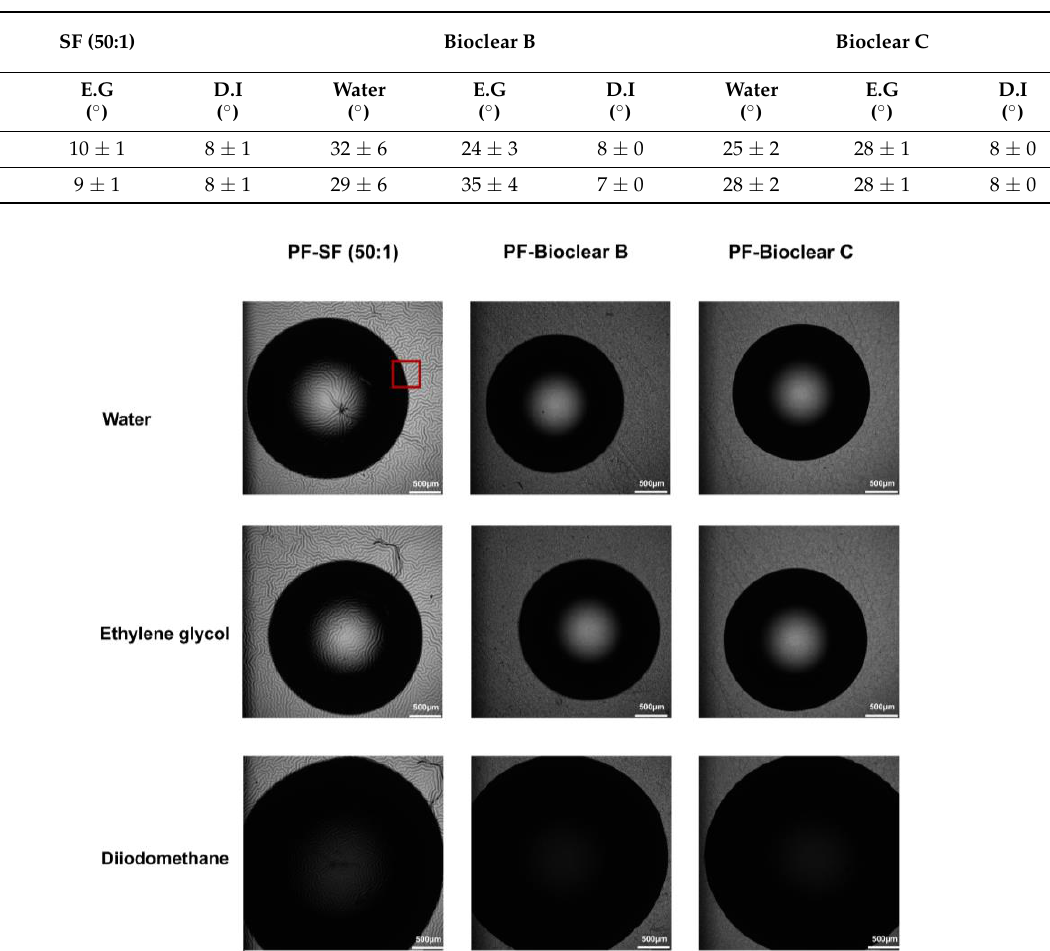
Table A7. SA values of water, ethylene glycol, and diiodomethane on PF-coated soft PDMS surfaces with different thicknesses.